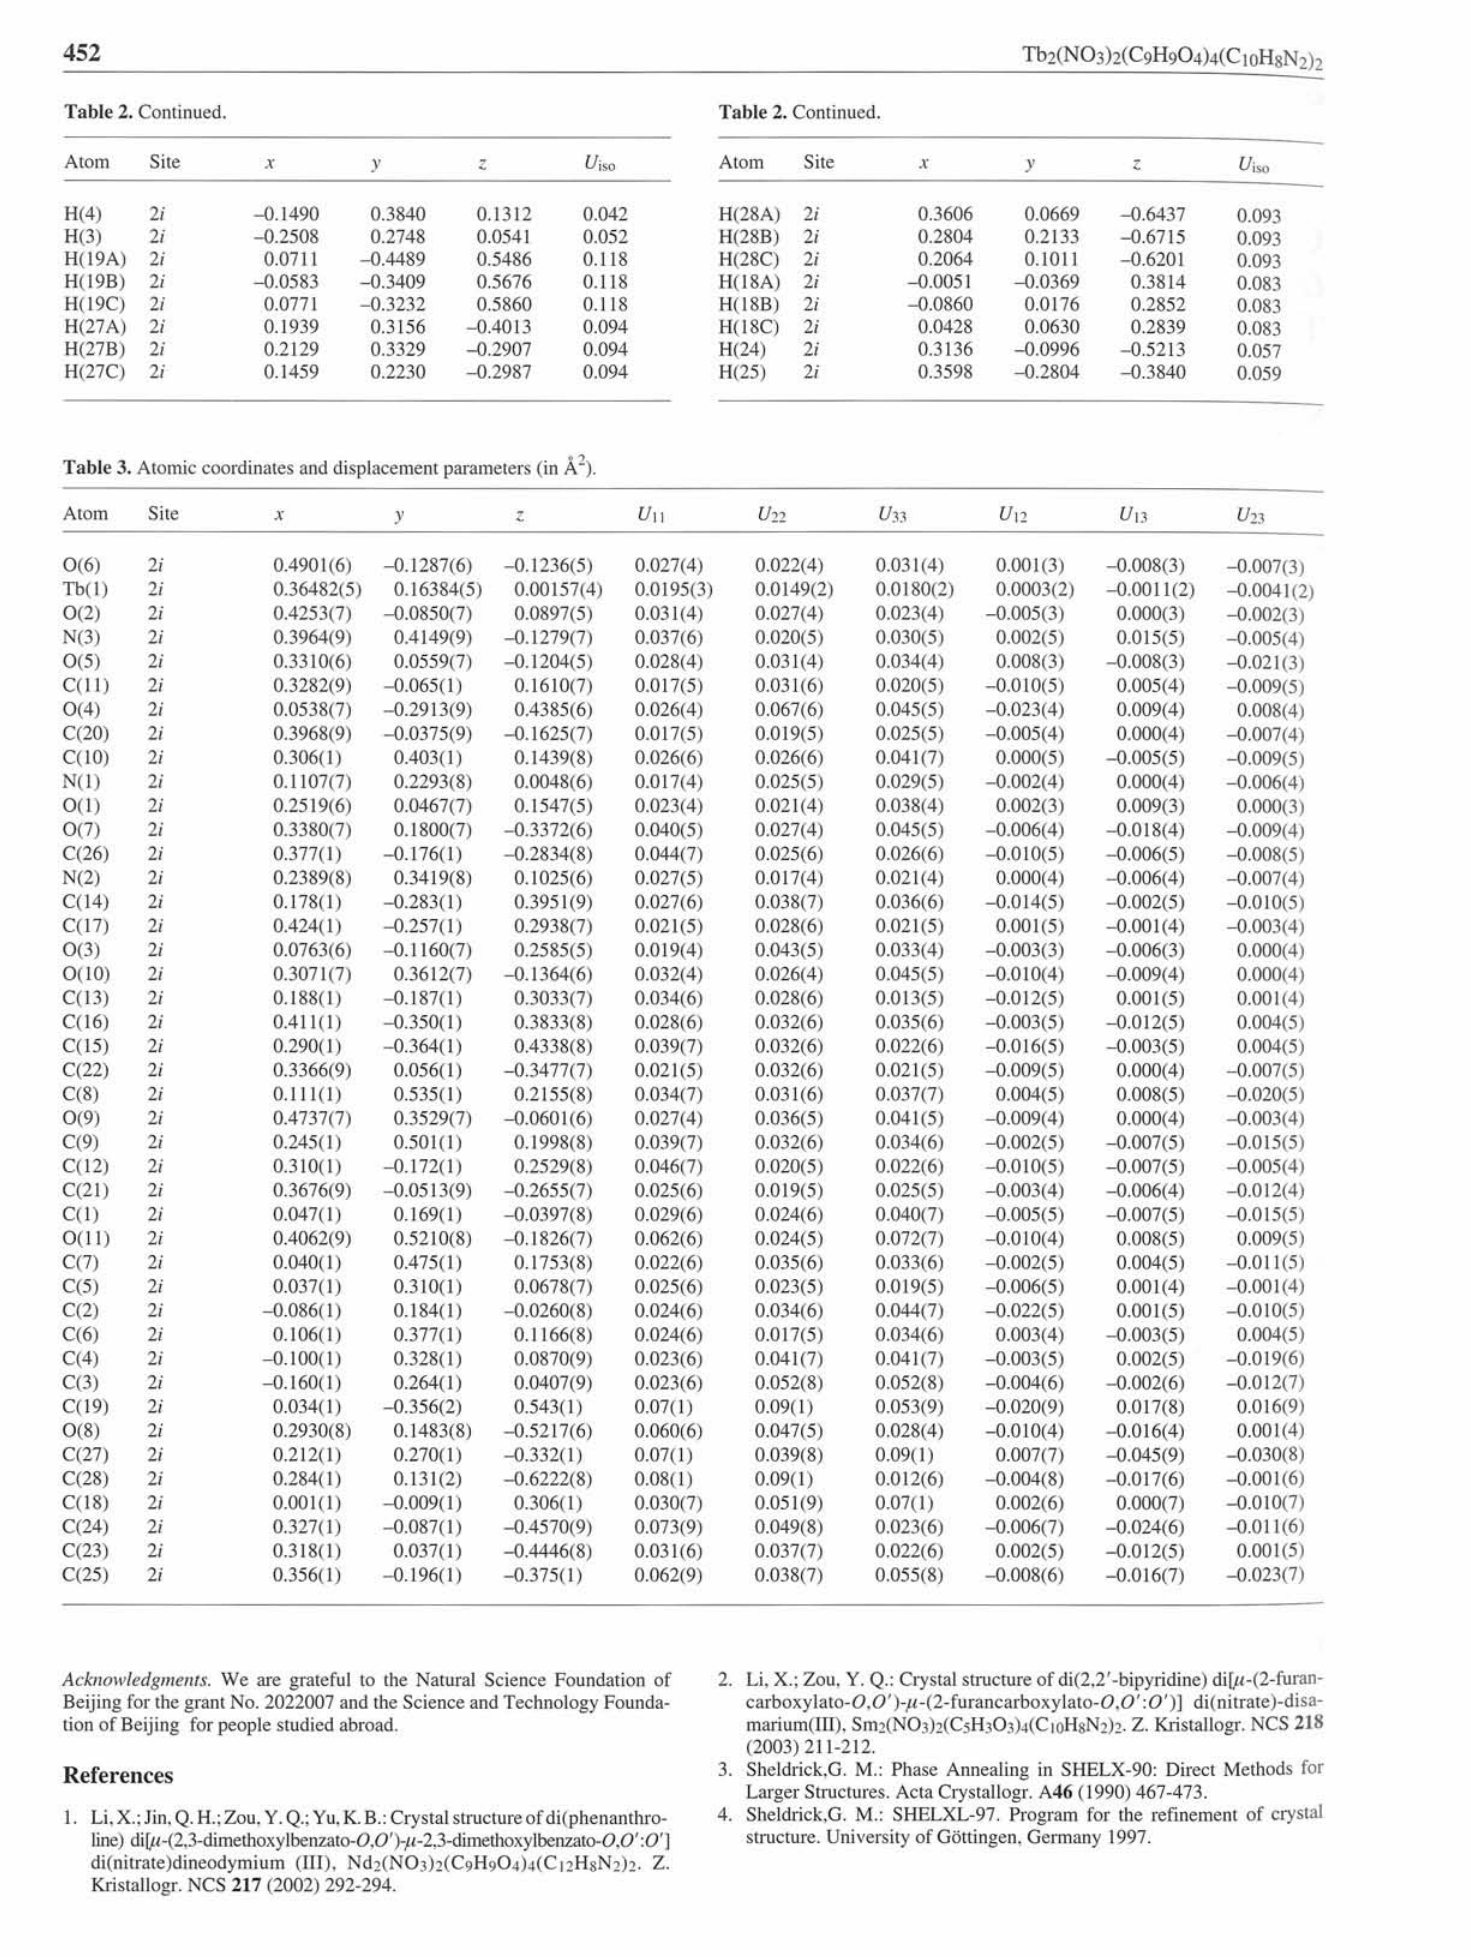
Table 3. Atomic coordinates and displacement parameters (in Â 2